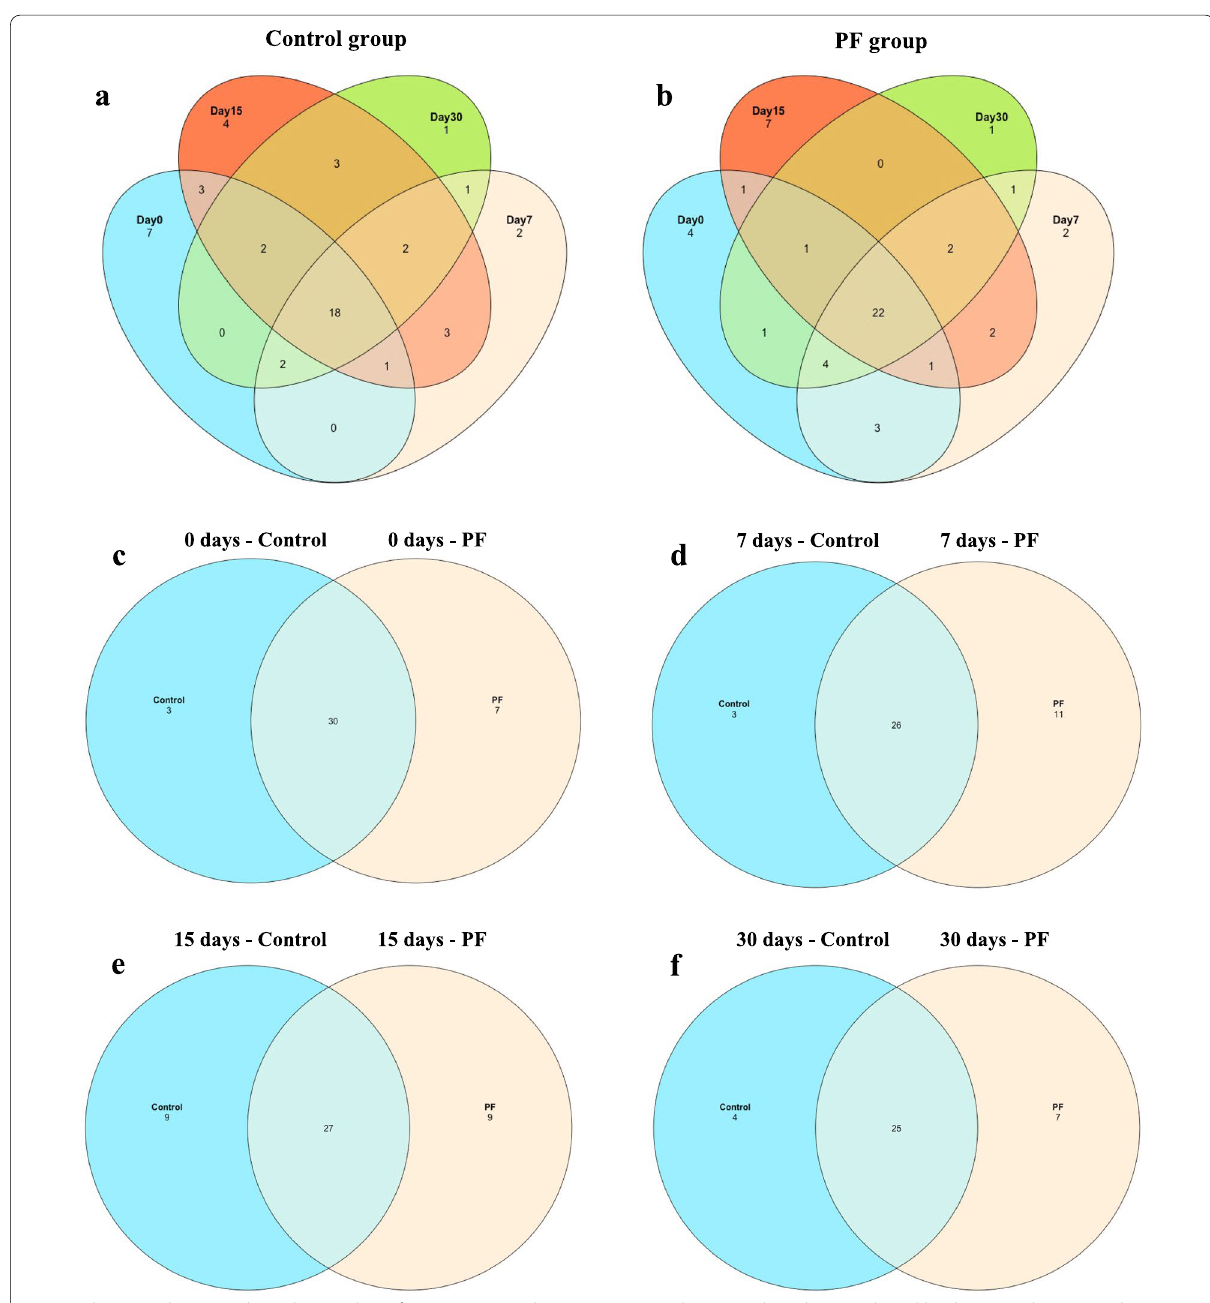
Fig. 4 The Venn diagrams show the number of core operational taxonomic units that were shared or not shared by the control group and treatment group individuals, depending on overlap. The common and specific genera in the a Control group. b PF group. c Day 0. d Day 7. e Day 15. f Day 30. Core genera were identified with a detection threshold of 0.001 in at least 90% of the samples and a 75% prevalence. Basal diet with no supplementation (CON), supplemented with L. reuteri BF-E7 L. salivarius BF-17 (PF; 1 +